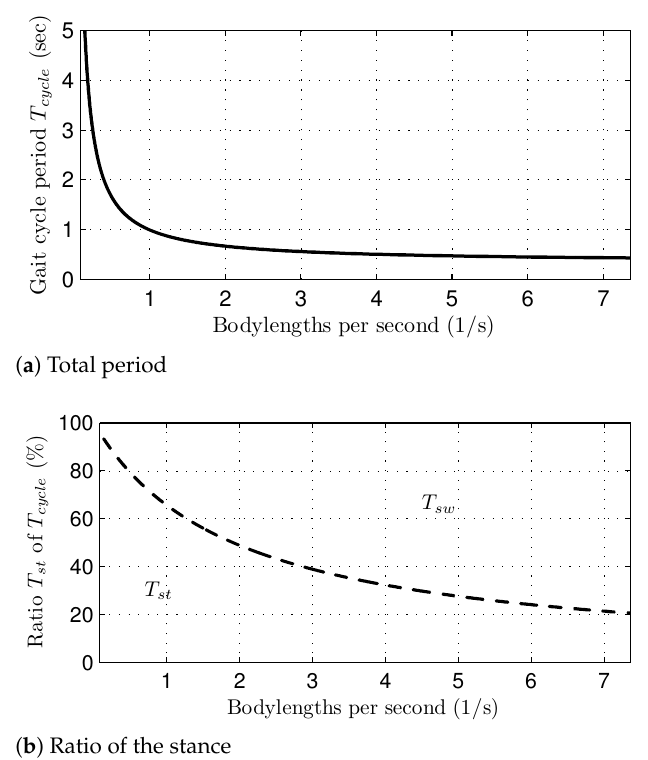
Figure 13. The total period and the stance ratio of one gait cycle in the simulation study: ( a ) total period and ( b ) ratio of the stance.